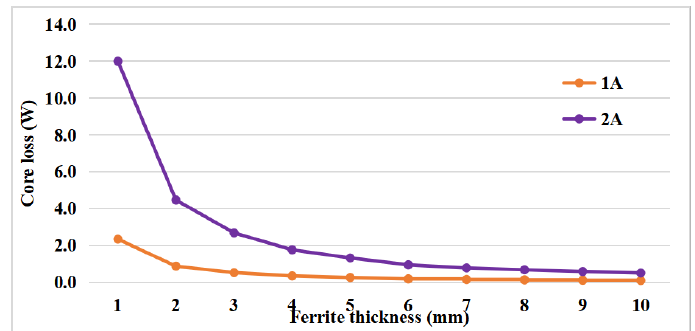
Figure 7. Core loss with varied core thickness and different current scales.